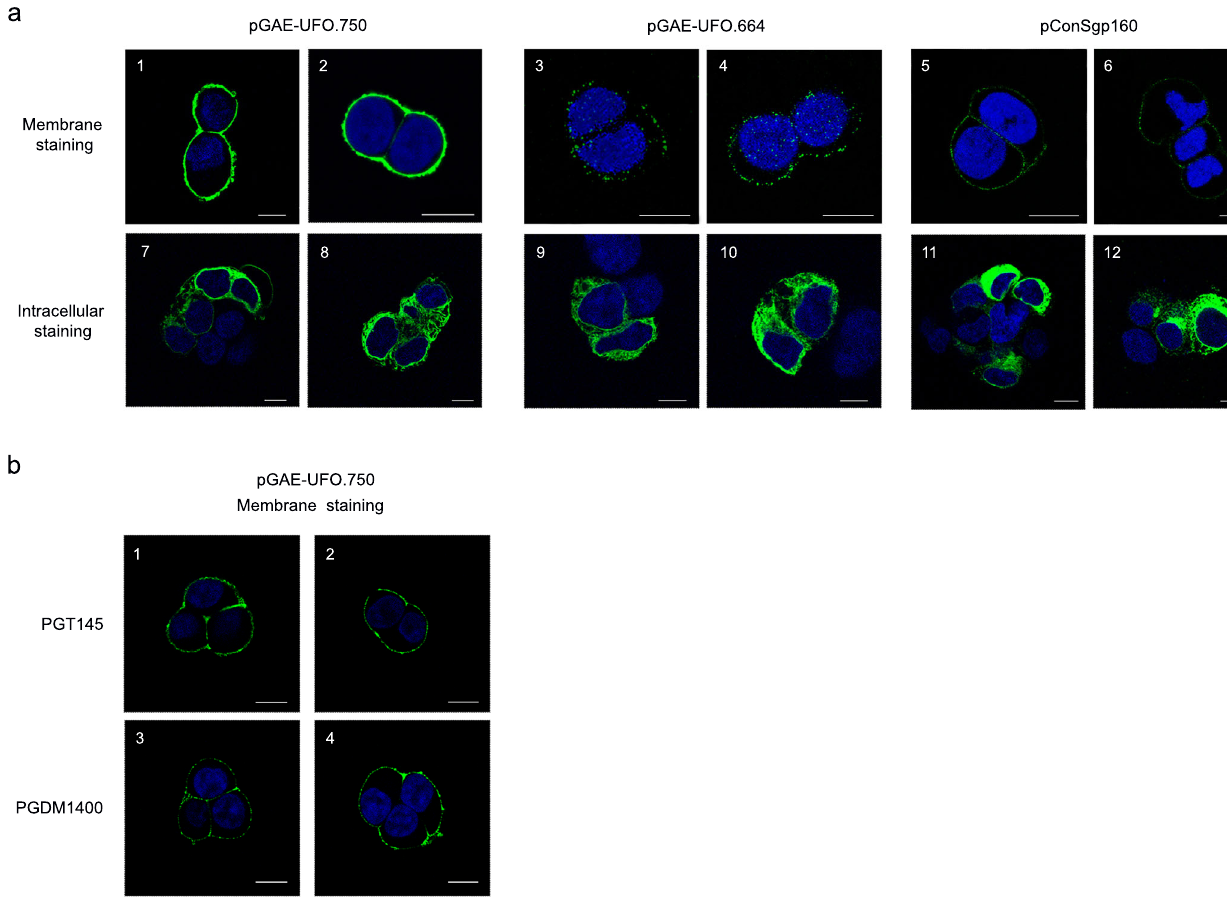
Fig. 1 ConSOSL.UFO expression form SIV-based transfer vectors. a 293T Lenti-X cells were transfected with SIV-based transfer vectors pGAE-UFO.664 and pGAE-UFO.750 or with pConSgp160, expressing parental ConSgp160 Env. Cells were membrane (top panels) or intracellular (bottom panels) stained with bNAb 2G12 and analyzed by CSLM. b 293T Lenti-X cells transfected with pGAE-UFO.750 were membrane stained with trimer speci fi c PGT145 (panels 1, 2) or PGDM1400 (panels 3, 4) bNAbs and analyzed by CSLM. Anti-human IgG Alexa Fluor 488 was used as secondary Ab. Nuclei were stained in blue by DAPI. Scale bars, 10 μ m. Images represent single central optical sections. Shown are results from one representative of n = 3